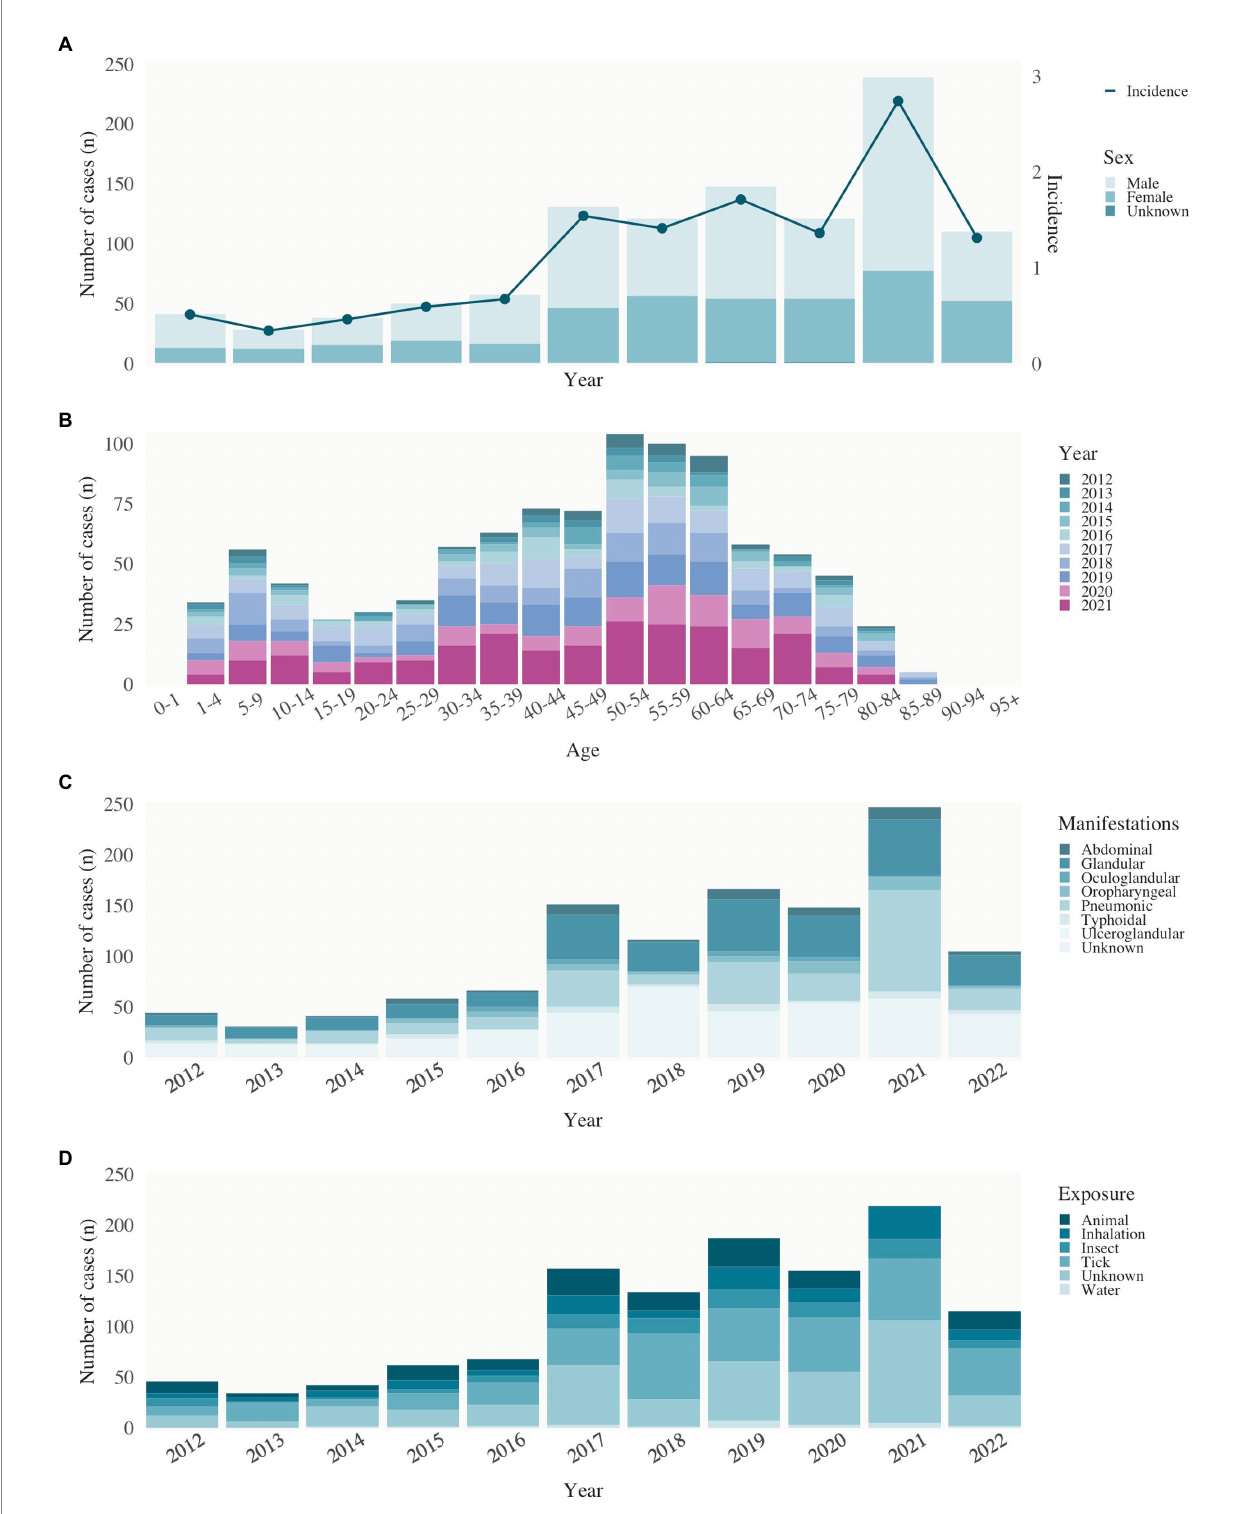
FIGURE 3 Tularemia epidemiology in human. (A) Human notified cases of tularemia (stacked bars) of male, female, and unknown sex and incidence (per 100,000 population, second y -axis) by year of notification, Switzerland, 2012–2022. (B) Age distribution of the reported cases by year of notification, Switzerland, 2012–2022. (C) Clinical manifestations of reported cases by year of notification, Switzerland, 2012–2022. (D) Source of infection of reported cases by year of notification, Switzerland,